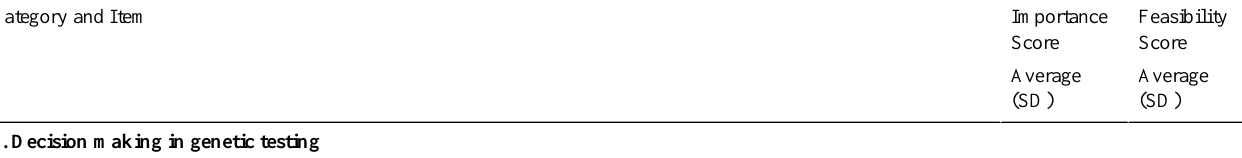
Feasibility (SD)Importance Score Score Average Average